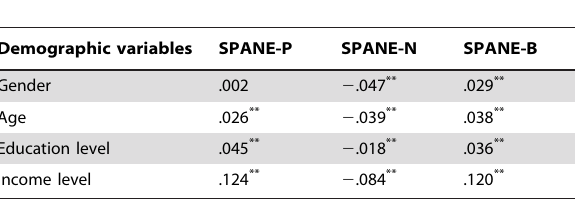
Table 5. Correlations between demographic variables and SPANE scores.